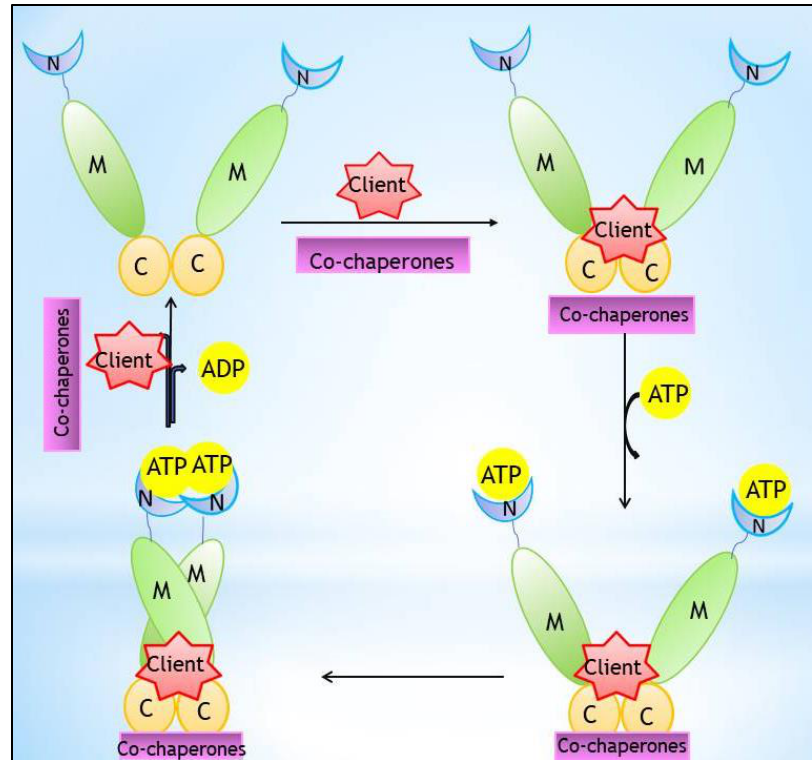
Figure 1. ATPase cycle in Hsp90.